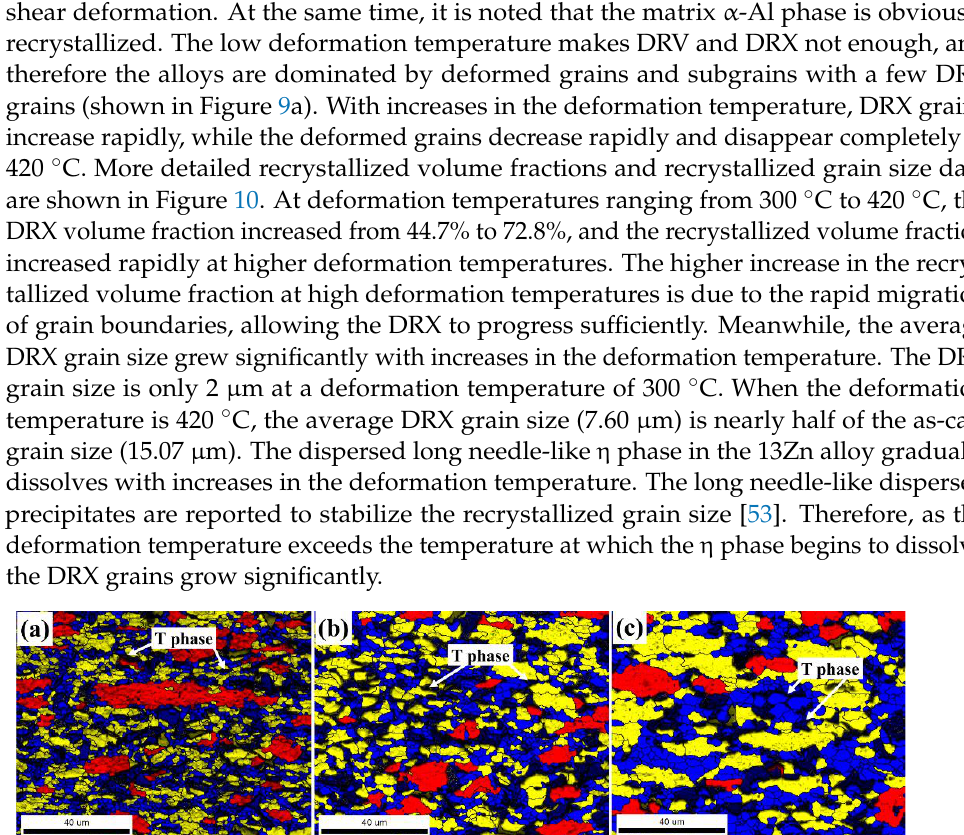
Figure 10. Recrystallized volume fraction and recrystallized grain size at different deformation tem- peratures.